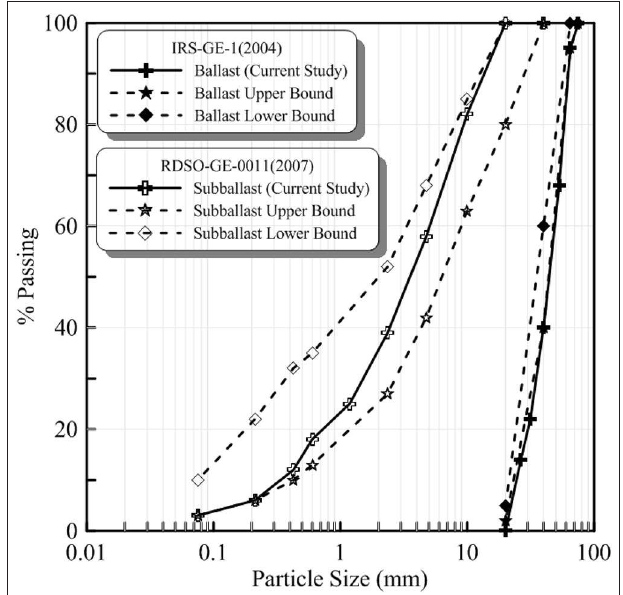
FIGURE 1 | Particle size distributions of ballast and sub-ballast used in this